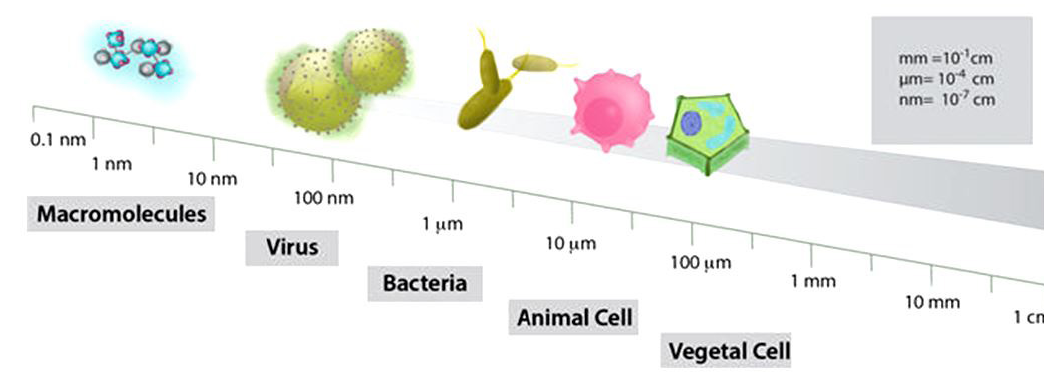
Figure 1. Viruses are extremely small (20-200 nm), smaller than bacterial cells (> 1000 nm), which in turn are smaller than animal and plant cells. nm = nanometer; μm = micrometer; cm = centimeter. Adapted from Melo (2018), with